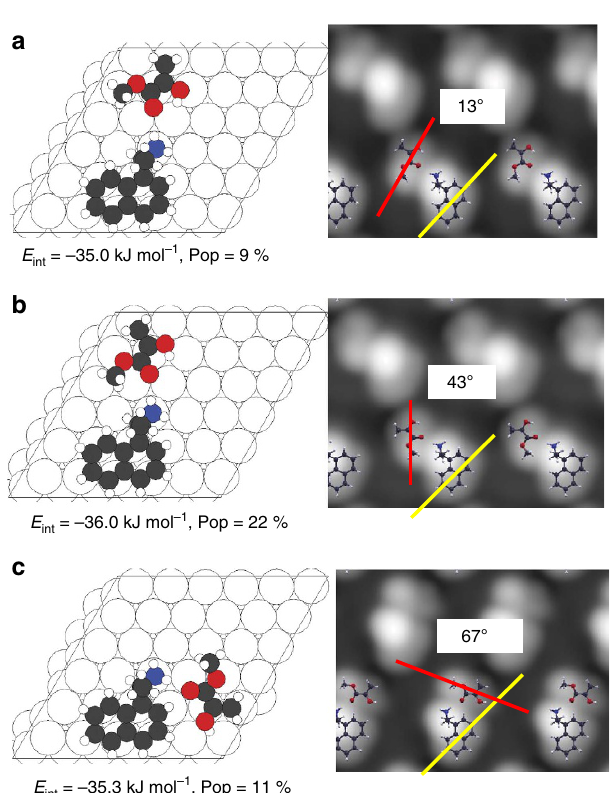
Figure 5 | Calculated structures of the docking complexes that form between exo-NEA and MP on Pd(111). Depictions of DFT-optimized structures of the most stable docking complexes formed between MP and exo-NEA adsorbed on the dibridge[6] site, indicated as a – c . The interaction energies calculated including van der Waals’ interactions are shown below each structure. The STM images simulated by the Tersoff–Hamman method are shown adjacent to each structure. The angles between the axis in the simulated images of the enol tautomer of MP, indicated by red lines, and the long axis of the naphthyl group of NEA, indicated by yellow lines, are also indicated. The relative population of each type of docking complex is calculated using a Boltzmann distribution and is reported below the respective